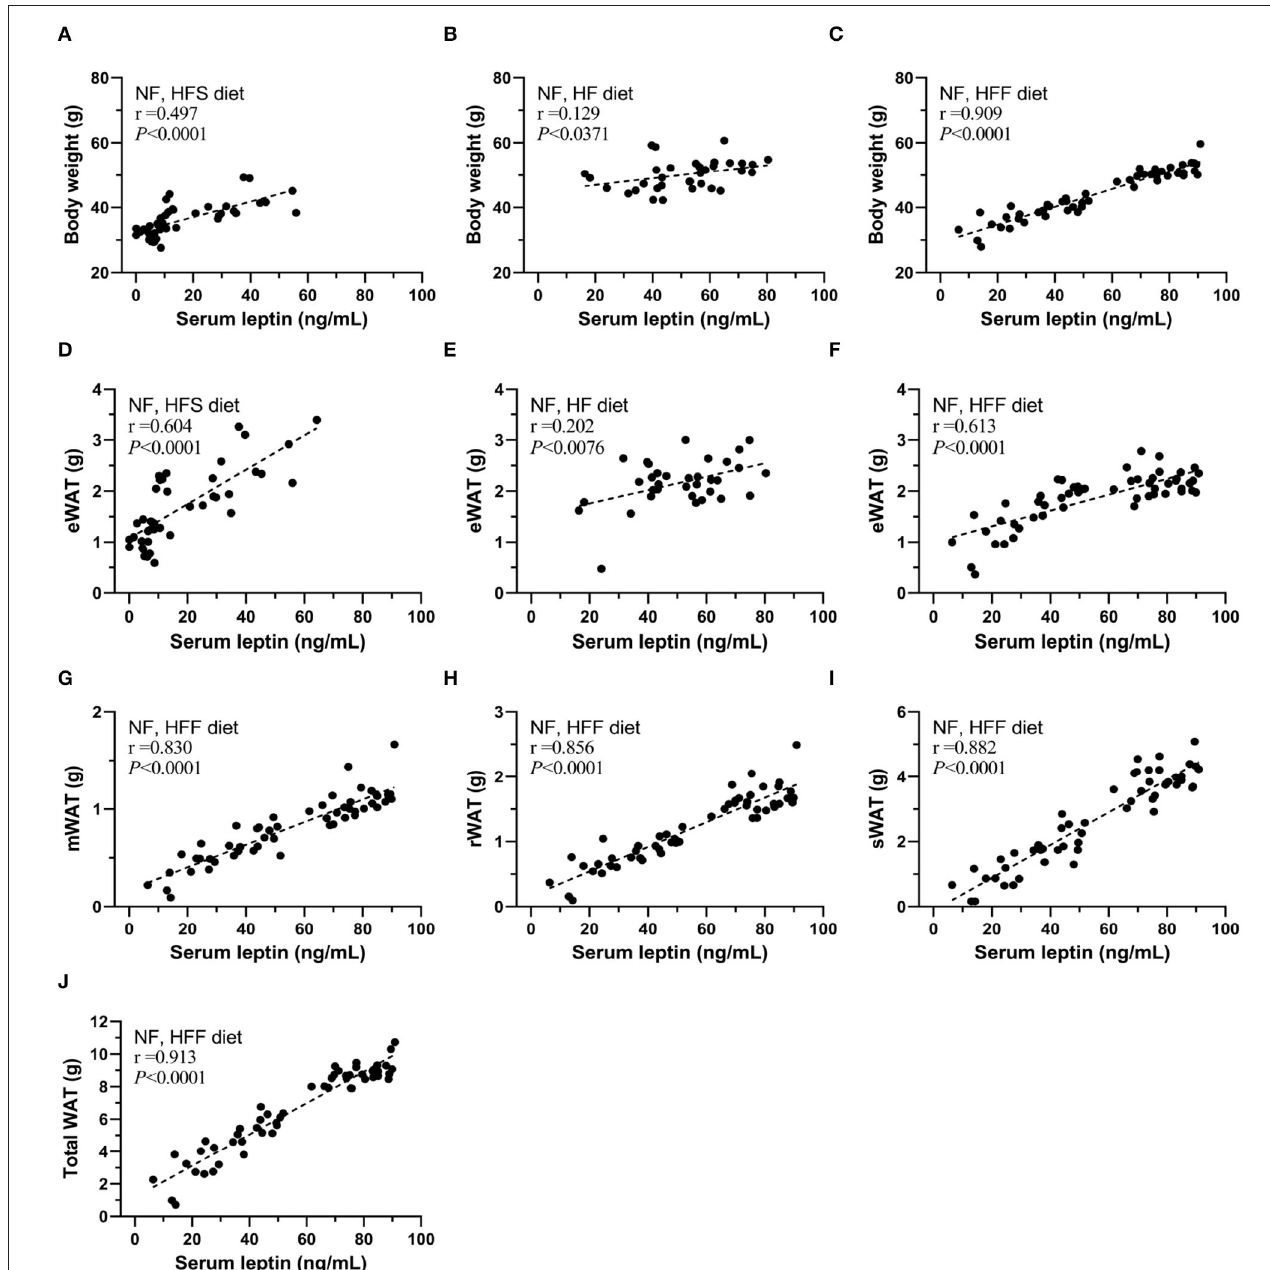
FIGURE 5 | Serum leptin levels correlated with body weight and WAT mass of mice of each group. The correlation between serum leptin and body weight of (A) NF and high-fat high-sucrose (HFS) groups, (B) NF and HF groups, and (C) NF and high-fat high-fructose (HFF) groups. The correlation between serum leptin and epididymal WAT (eWAT) of (D) NF and HFS groups, (E) NF and HF groups, and (F) NF and HFF groups. The correlation between serum leptin and (G) mesenteric WAT (mWAT), (H) perirenal WAT (rWAT), (I) subcutaneous (sWAT), (J) total WAT of NF and HFF groups. Data are mean ± SD ( n = 8–16 per group). The correlation coefficient was analyzed by the Pearson’s correlation and represented as r value ( p <